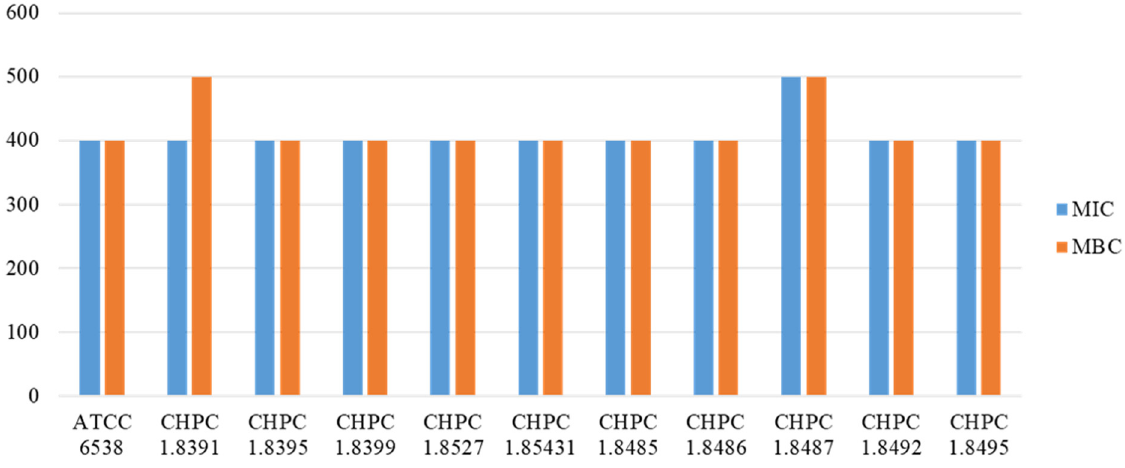
Figure 3. The MIC value and MBC value of 11 strains .